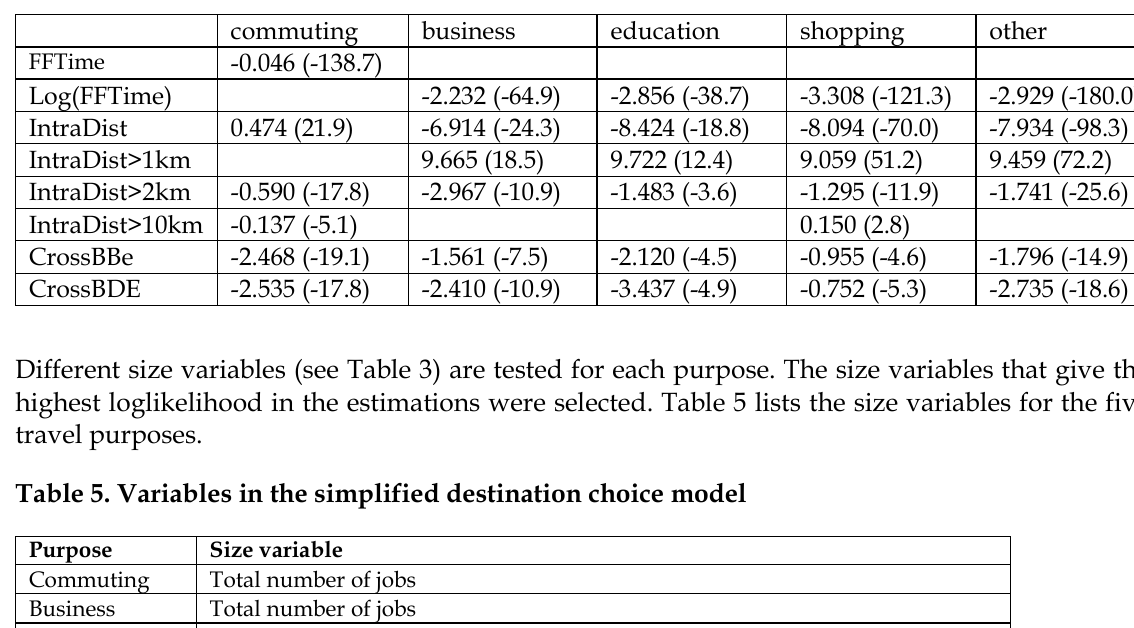
Table 4. Model estimation for destination choice models by purpose (t ratios in brackets). Empty cells indicate that coefficients were insignificant.